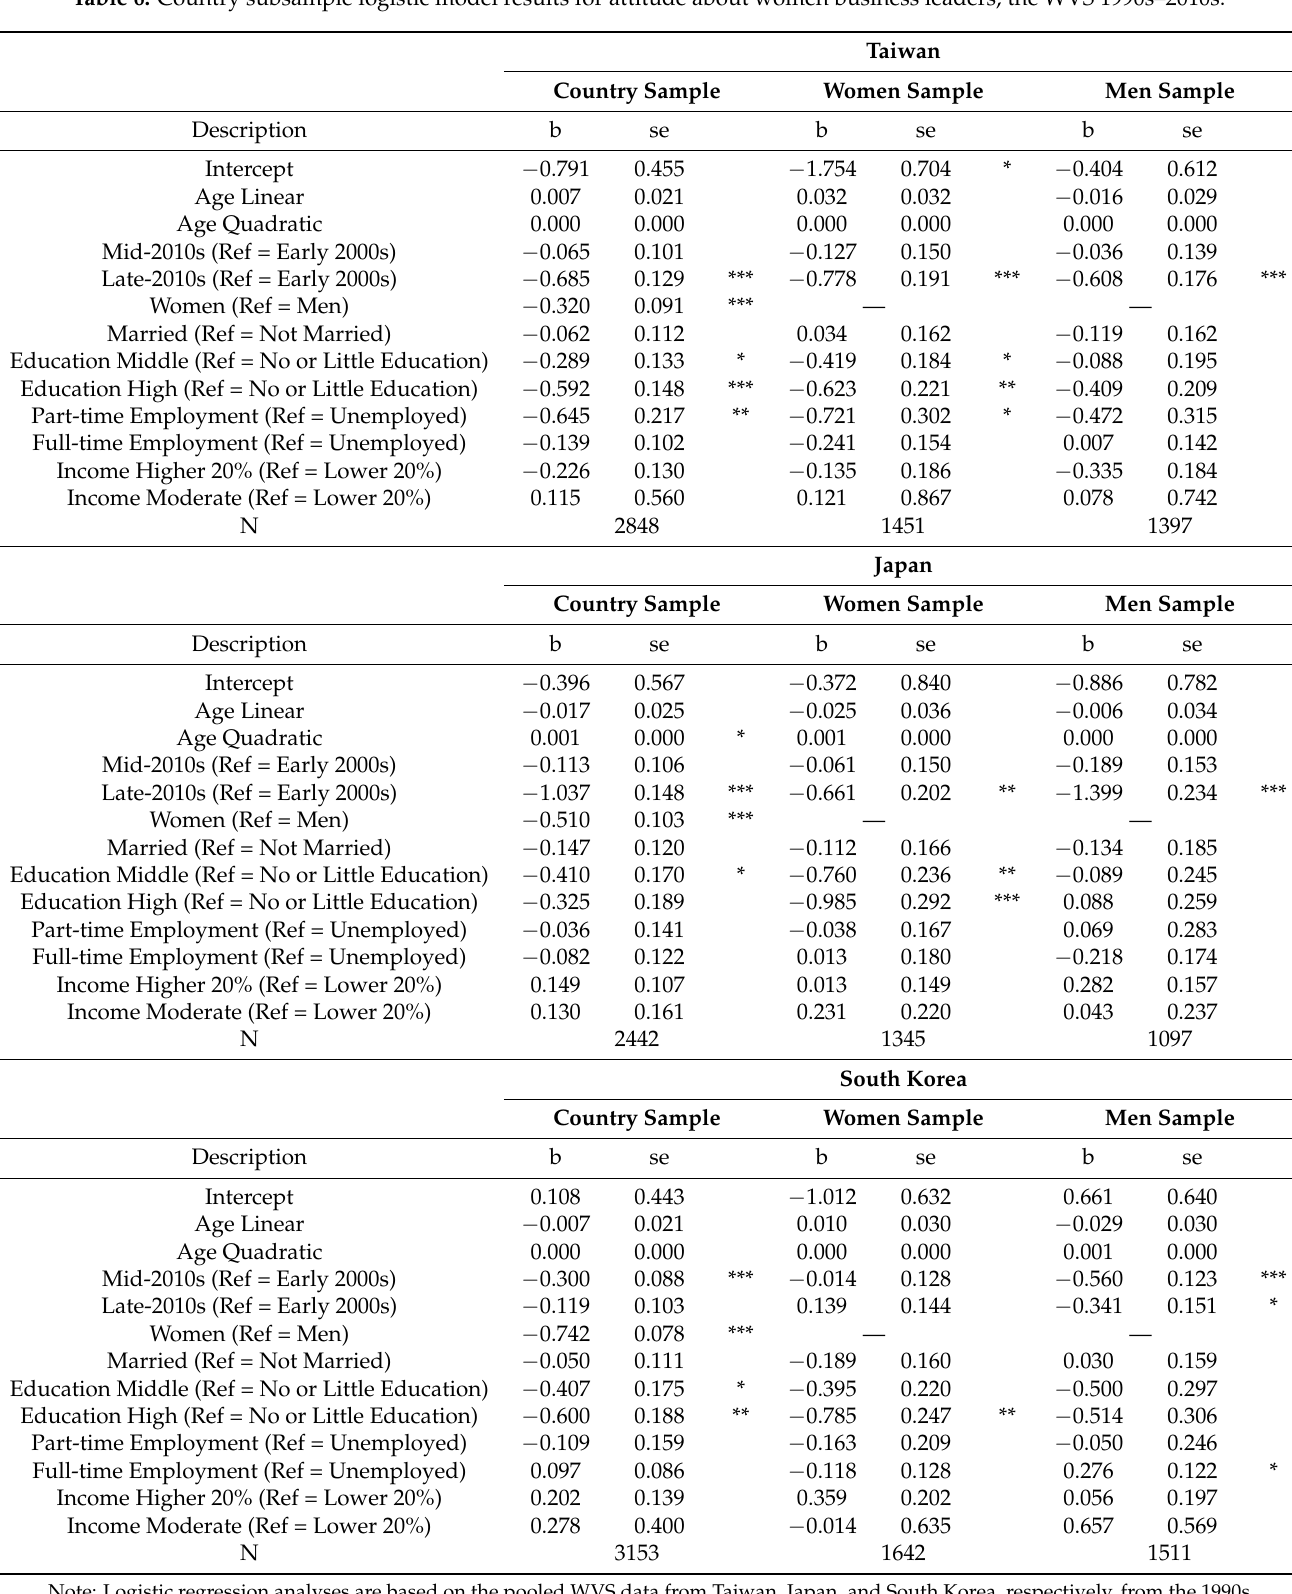
Table 6. Country subsample logistic model results for attitude about women business leaders, the WVS